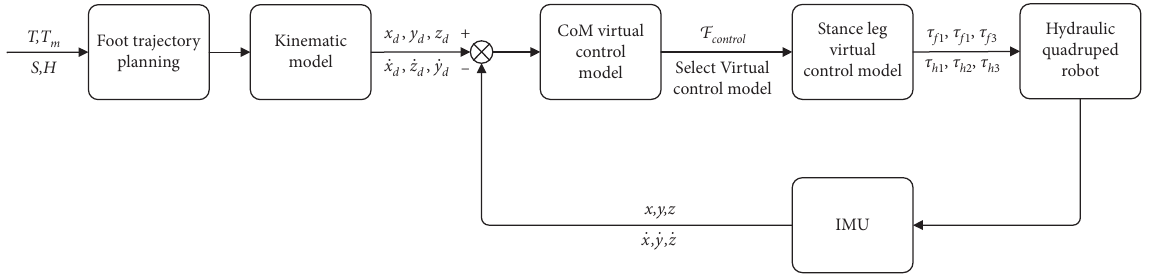
Figure 3: Body disturbance control block